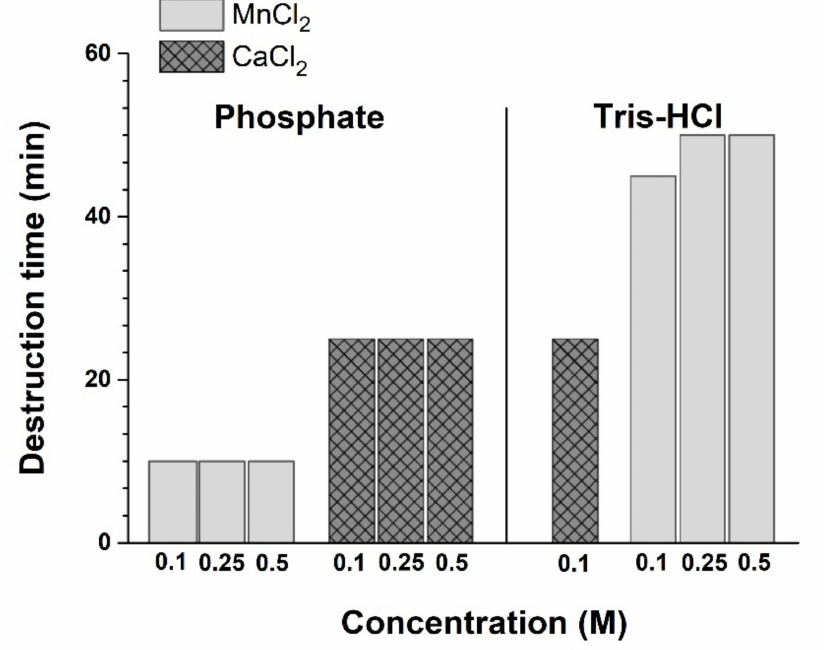
Figure 4. Stability of microcapsules prepared with reduced salt concentration PBS pH 7.2 and Tris-HCl buffer pH